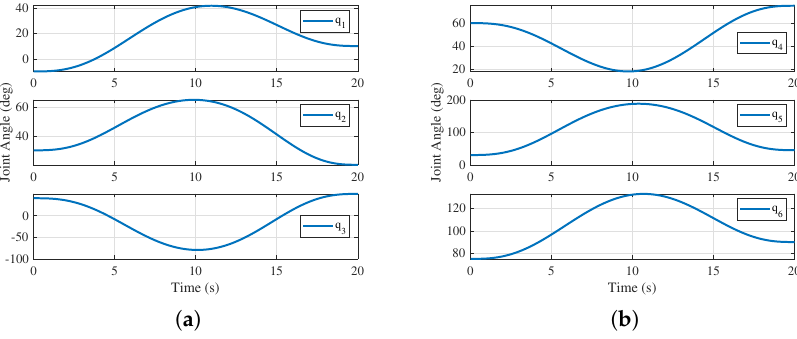
Figure 14. Angular variation curves of i th joint, where ( a ) i = 1, 2, 3, and ( b ) i = 4, 5, 6.